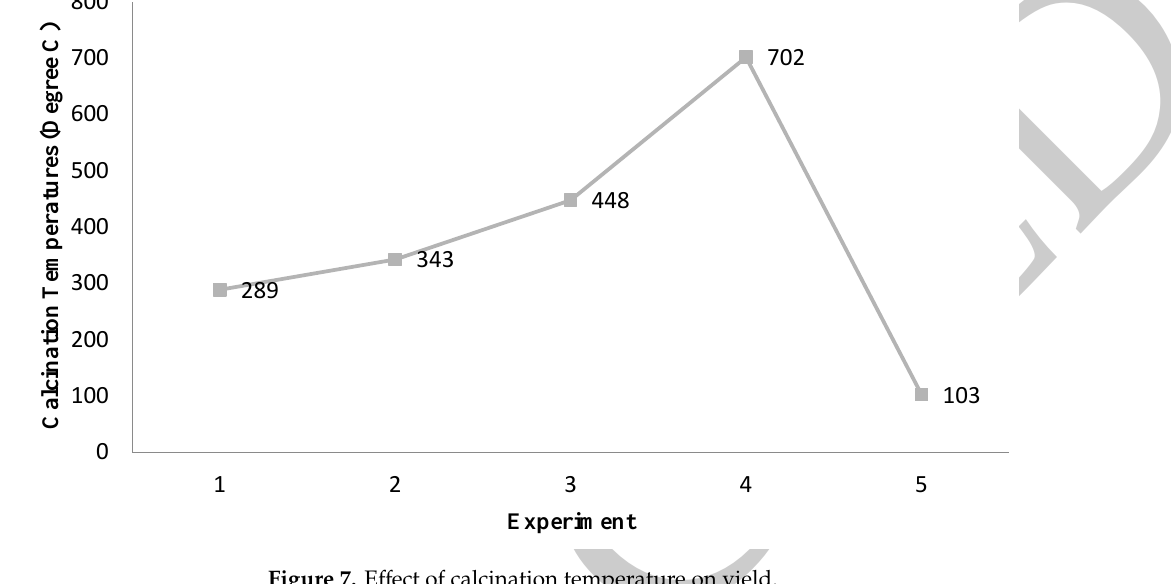
Figure 7. E ff ect of calcination temperature on yield. Figure 7. Effect of calcination temperature on yield. Figure 7. Effect of calcination temperature on yield.